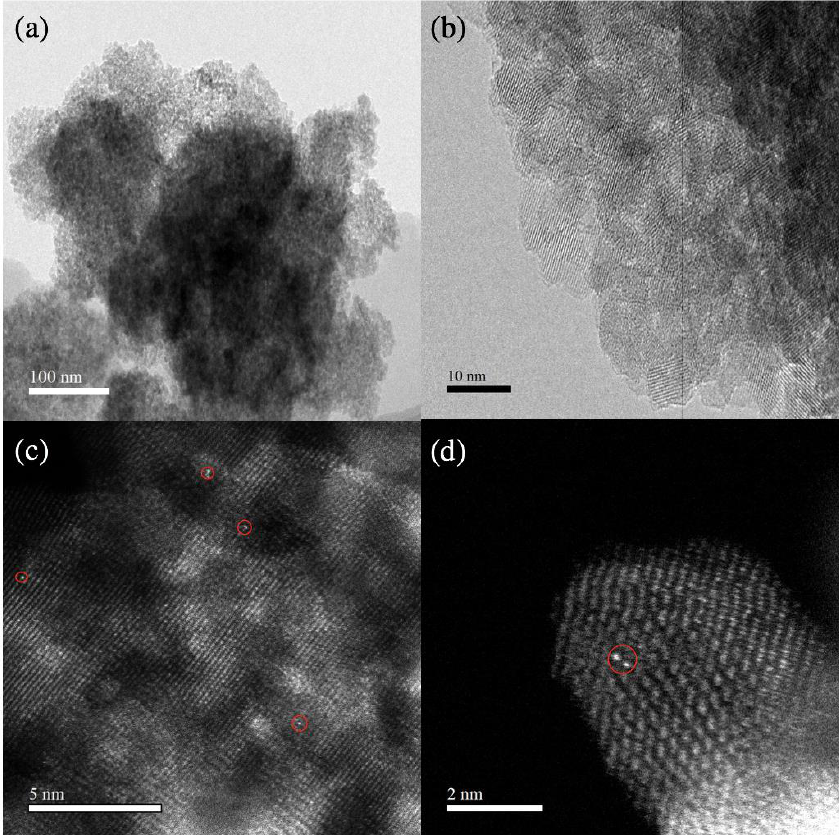
Figure 3. TEM and spherical aberration electron microscopic images of Au 1 @15-crown-5 at different magnifications: ( a , b ) TEM images; ( c , d ) HAADF-STEM images. magnifications: ( a , b ) TEM images; ( c , d ) HAADF-STEM